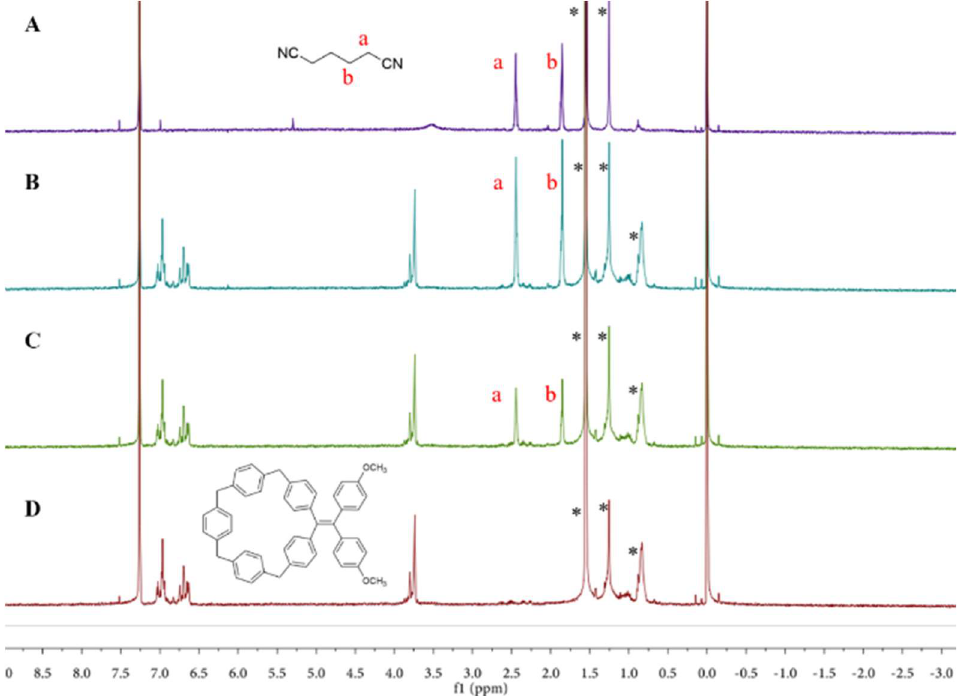
Figure 4. ( A ) 1 H NMR spectra of DCB (1 mM), ( B ) Partial 1 H NMR spectra of the mixed solution of PCP[5]-TPE (1 mM) and DCB (1 mM), ( C ) Partial 1 H NMR spectra of the mixed solution of PCP[5]-TPE (1 mM) and DCB (2 mM), ( D ) 1 H NMR spectra of PCP[5]-TPE (1 mM). * = solvent.